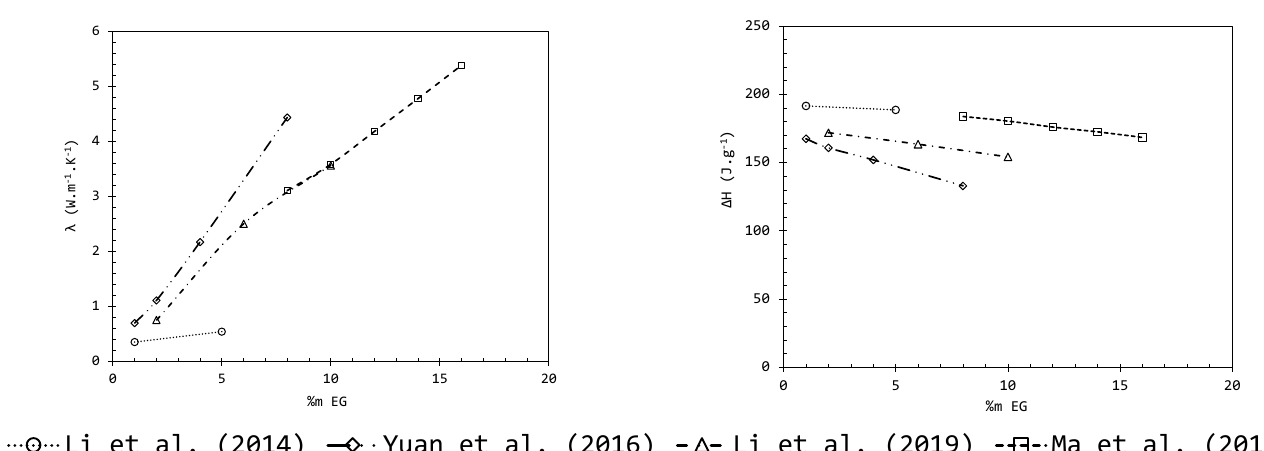
Figure 11. Influence of the expanded graphite (EG) mass fraction on the PCM’s conductivity ( left ) and latent heat of melting ( right ) in the works of Li et al. (2014) [48], Yuan et al. (2016) [27], Li et al. (2019) [28] and Ma et al. (2019) [49].